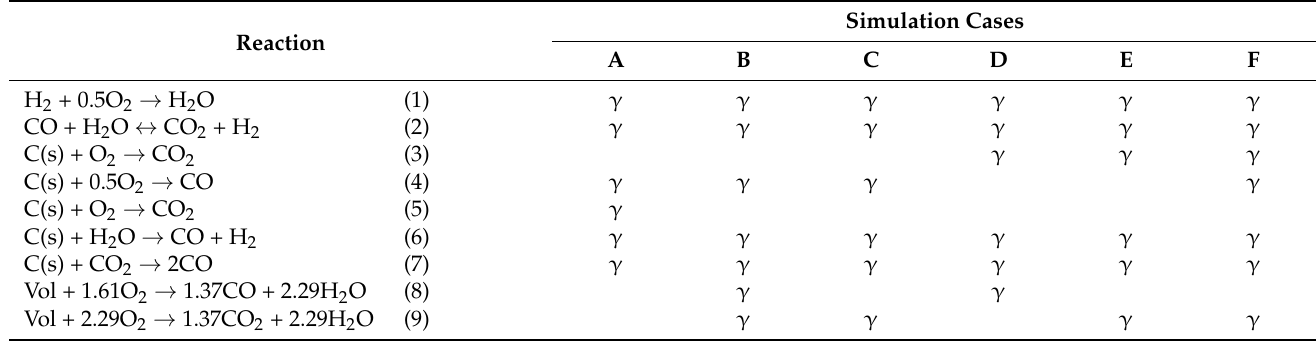
Table 3. Numerous preliminary models for the evaluation of the best